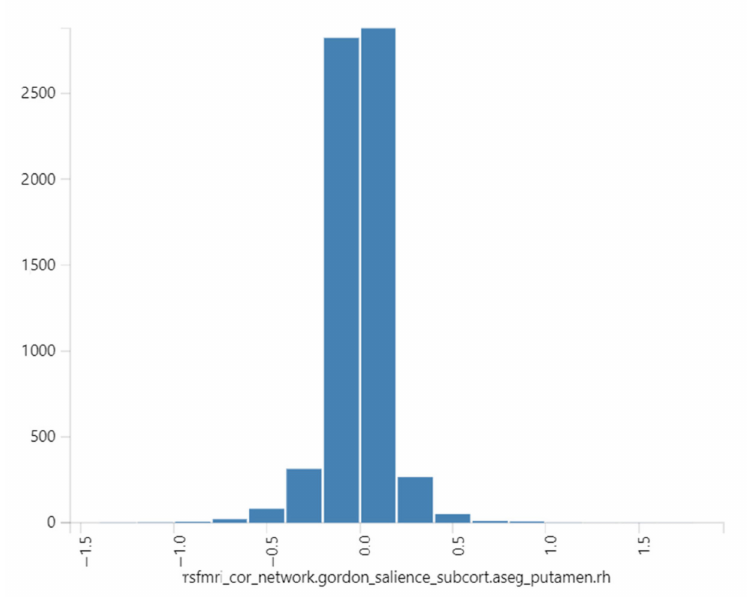
Figure A1. Distribution of our